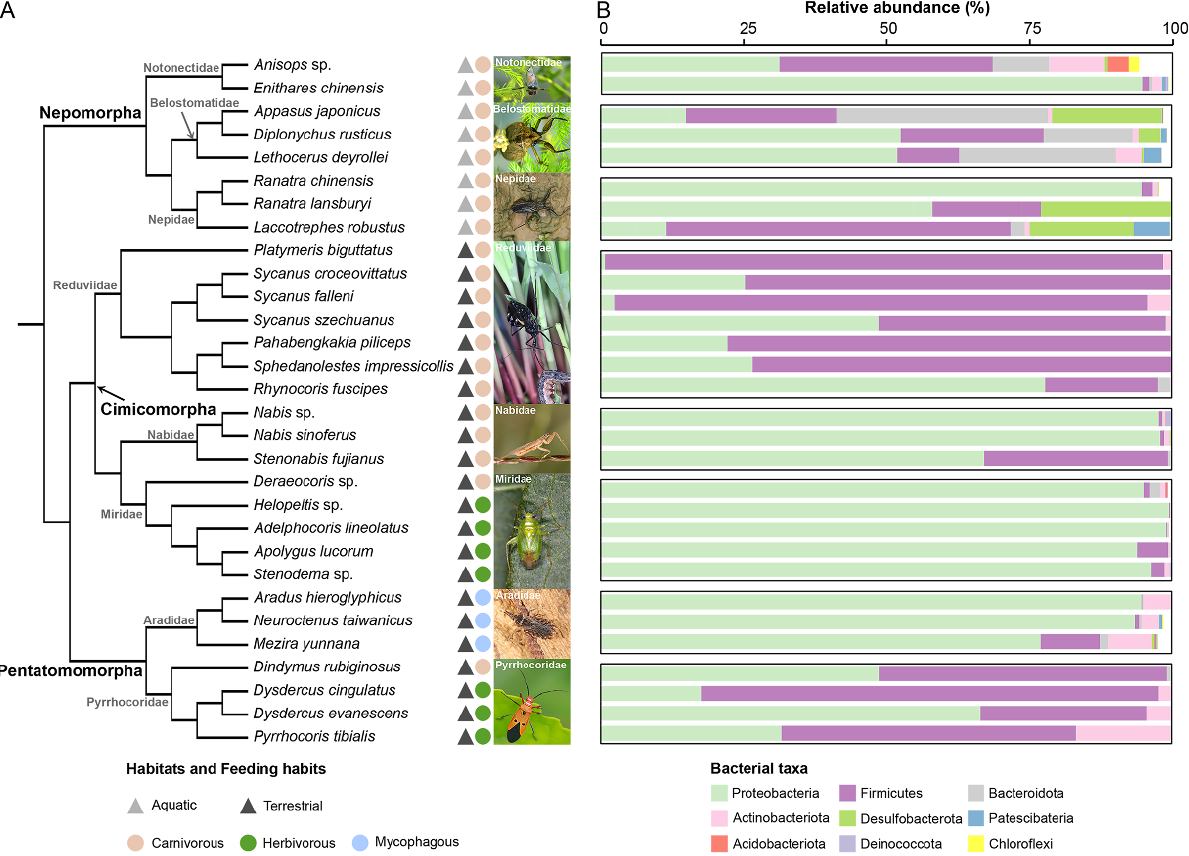
Figure 1. The gut bacterial composition at the phylum level for 30 heteropteran species. ( A ) Phylogeny of the host species. The phylogenetic tree of the 30 selected heteropteran species was reconstructed using Mesquite 3.51 [41], with the topology constrained to recently published phylogenetic studies of true bugs [42–45]. Insect infraorder and family are indicated at nodes. The habitat ecology and feeding habit are labeled by color. Typical ecological photos of true bugs from the same families are also shown and all photos are taken by authors. ( B ) The relative abundance of gut bacterial phylum estimated from the 16S rRNA gene amplicon sequencing data. Bacterial phyla with abundance of below 1% are not shown.